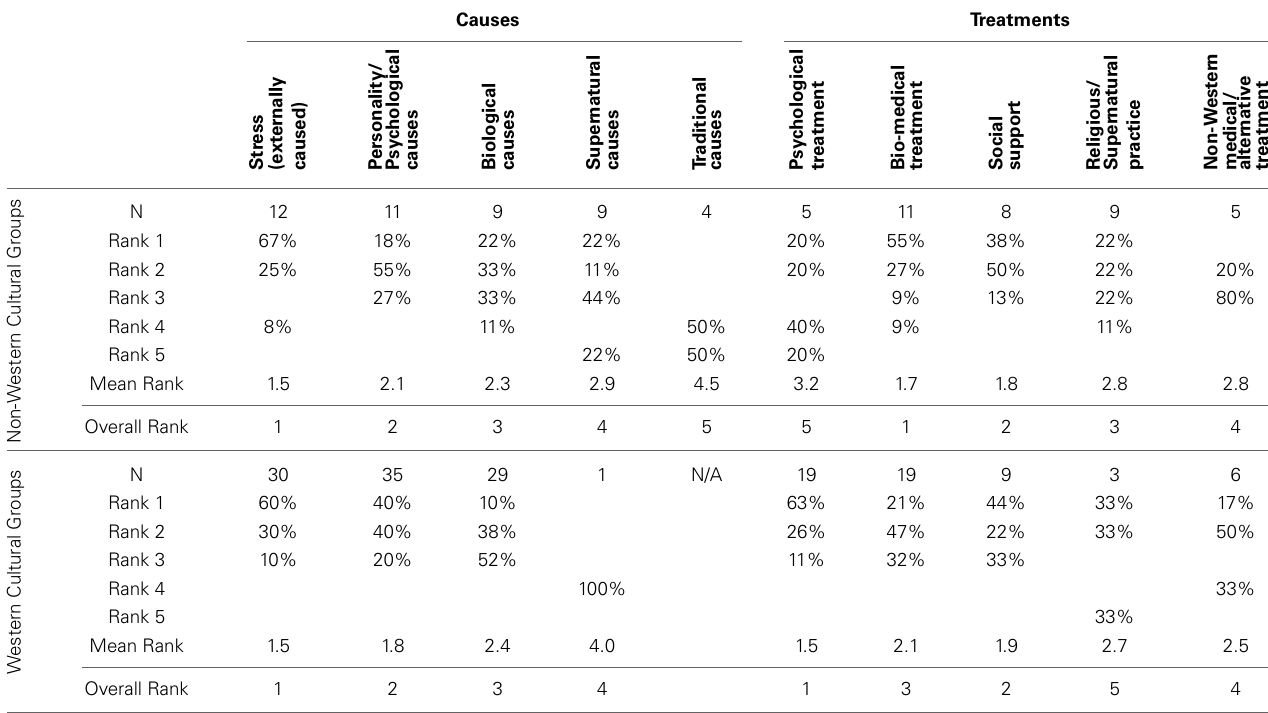
Note: Overall ranks were based on mean